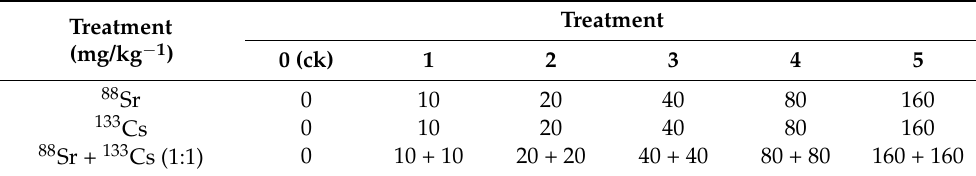
Table 1. Concentration of 88 Sr, 133 Cs, and 88 Sr + 133 Cs applied in soils. Treatment (mg/kg − 1